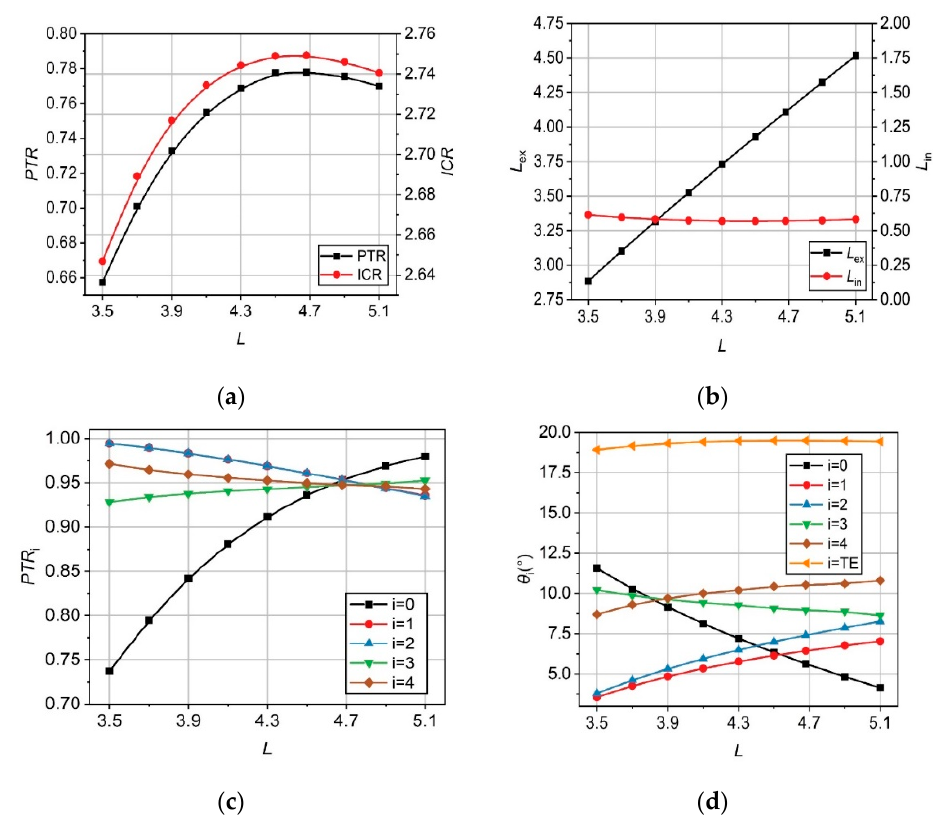
Figure 6. Influences of the length limit on ( a ) the total pressure recovery and ICR; ( b ) the length distribution; ( c ) the total pressure recovery of a single shock; and ( d ) the flow turning angle.